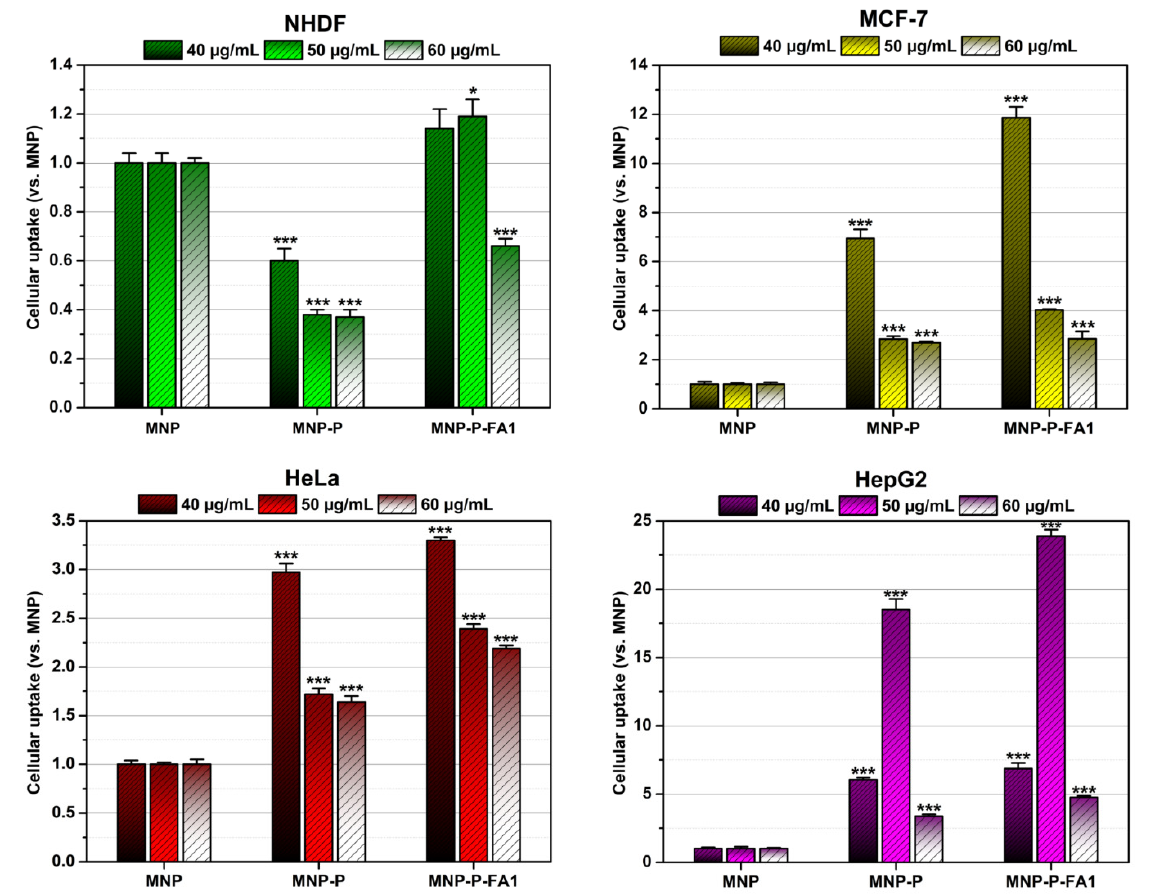
Figure 10. Cellular uptake of MNP, MNP-P and MNP-P-FA1 (40, 50 and 60 µ g/mL) in normal human dermal fibroblasts (NHDF), breast adenocarcinoma (MCF-7), cervical adenocarcinoma (HeLa) and hepatocellular carcinoma (HepG2) cells after 24 h. Experiments were performed in triplicate; iron contents were determined with the thiocyanate method, and nanocarrier uptake was expressed as fold change of values obtained for MNP incubation. * p < 0.05, *** p < 0.001 vs. MNP (for each concentration, Student’s t -test).